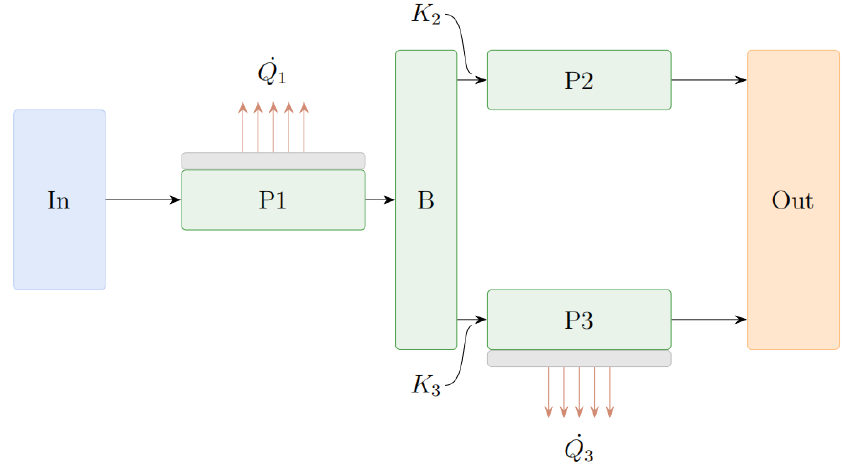
Figure 3. Geometry of the test cases. Table 1. Test cases matrix.